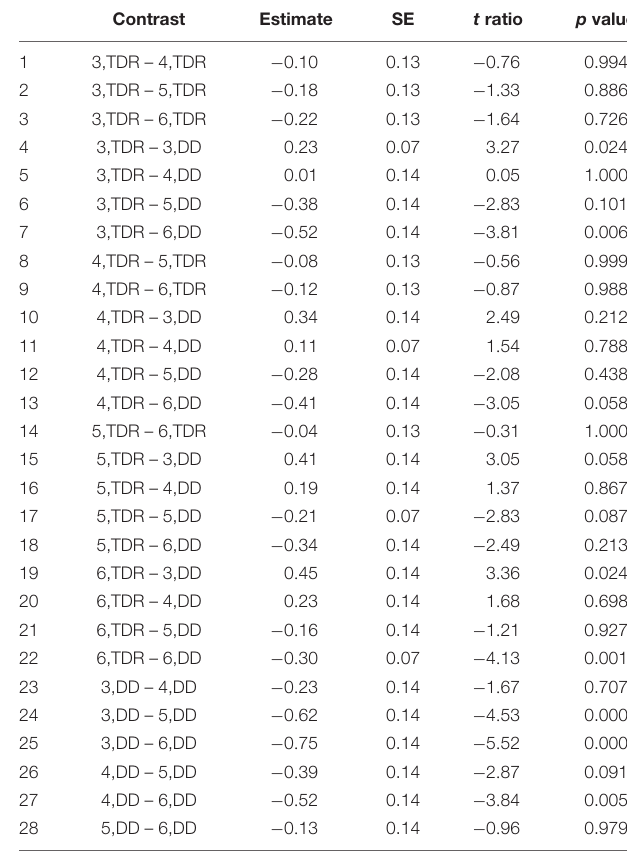
TABLE 5 | Non-words post hoc comparisons on the z -scores using Tukey